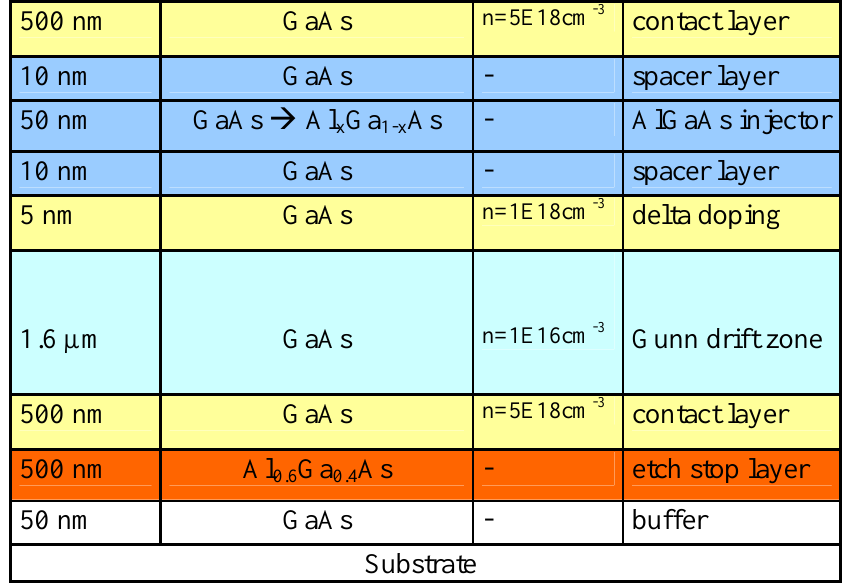
Table 1. Gunn diode layer